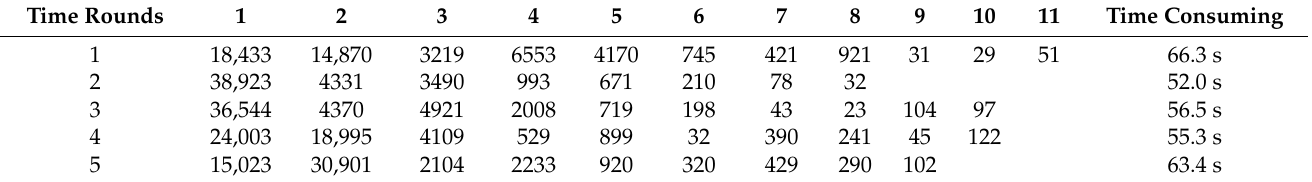
Table 5. The results of the number of alarms contained in the cluster and the number of algorithms calls in five experiments. Time Rounds